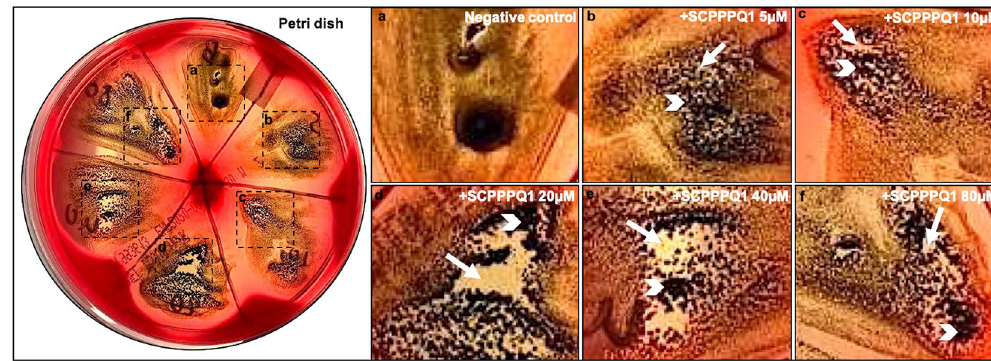
Figure 2. Determination of the working concentration of SCPPPQ1 that affect P. gingivalis growing conditions. Comparison of the difference in growth of the bacteria on a blood agar petri dish in ( a ) the presence of buffer alone (negative control) or ( b – f ) various concentrations of + SCPPPQ1. ( b – f ) Enlargements of the boxed areas in the blood agar plate (left panel). ( a ) Under control conditions the bacteria formed a relatively uniform layer that appeared black in photographs, ( b – f ) while in presence of proteins, this layer was interrupted producing a mosaic of black areas containing bacteria (white arrowhead) and white areas of various sizes that indicate absence/paucity of bacteria (white arrow). Qualitative evaluation suggests that the effect of SCPPPQ1 on the bacteria (white areas) started at 5 µM (weak) and plateaued at 20 µM (see Table 1). These results are representative of three experiments.